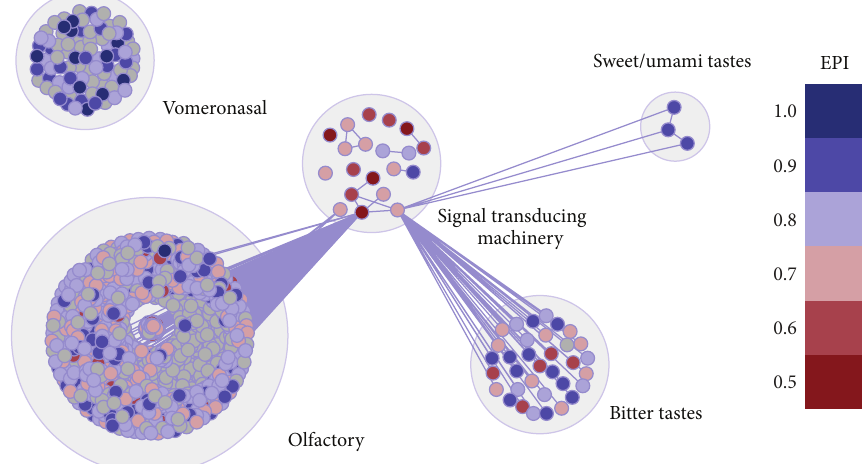
Figure 7: Graphical representation of Mus musculus chemosensory network. EPI values are plotted on each node by a color scale. Higher plasticity is indicated by bluish colors and lower plasticity by reddish colors. The other networks are not shown in this paper. Nodes represent protein coding genes and edges, functional